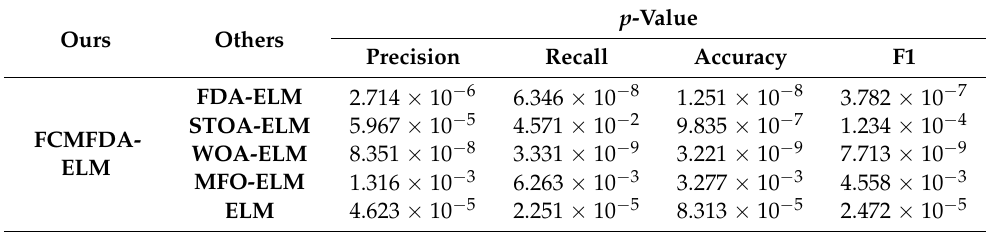
Table 11. T -test results of FCMFDA-ELM and other algorithms on four indicators (URPC).